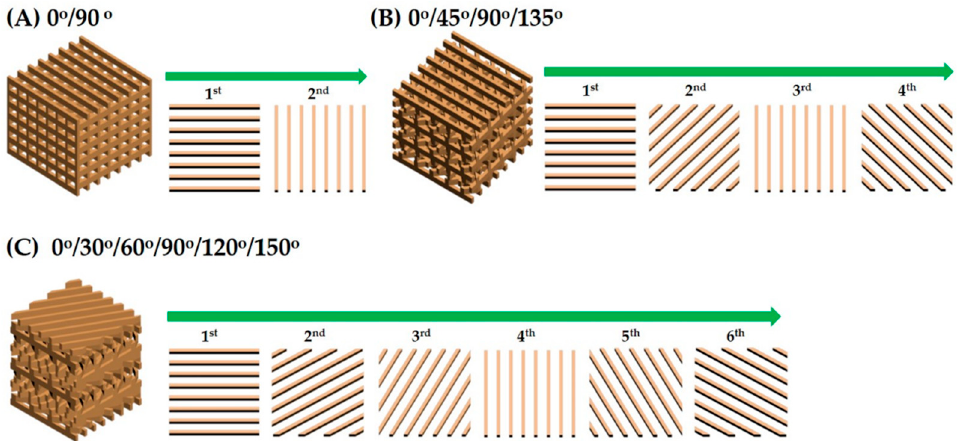
Figure 1. Schematic diagram showing the porous structures of various CaP scaffolds with different pore orientations: ( A ) 0°/90°, ( B ) 0°/45°/90°/135°, and ( C ) 0°/30°/60°/90°/120°/150° with their top-down view of the repeating CaP frameworks.